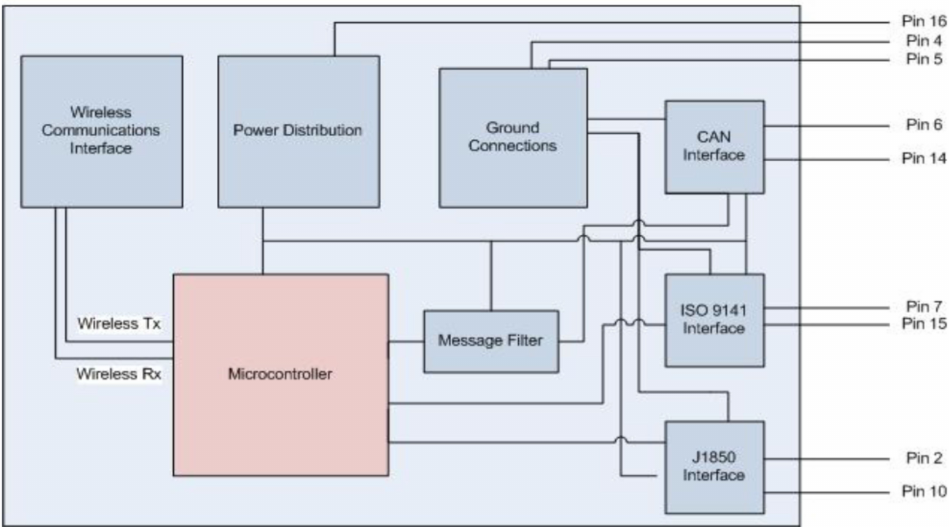
Figure 3. The vehicle data network structure connected to the CAN